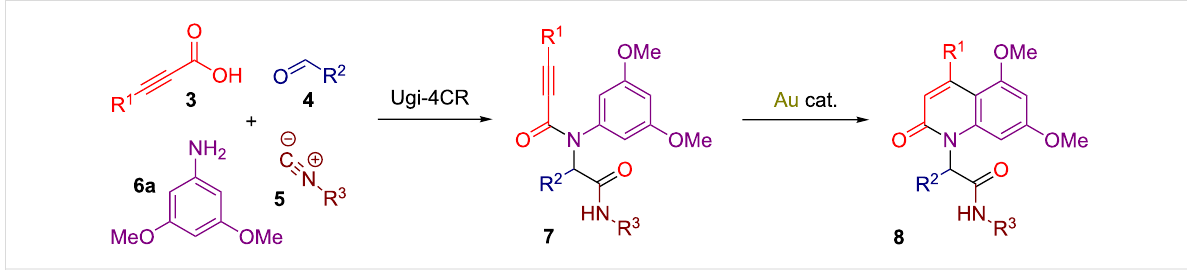
Table 1: Screening of the conditions for the intramolecular hydroarylation of the Ugi adduct 7a . a